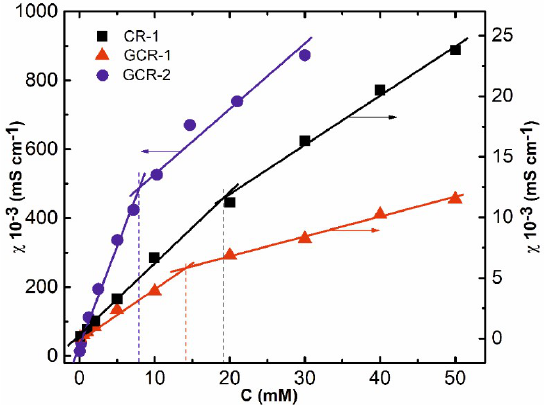
Figure 1. Concentration dependence of specific conductivity ( χ ) of water solutions of CR-1, GCR-1 and GCR-2, 25 °C.